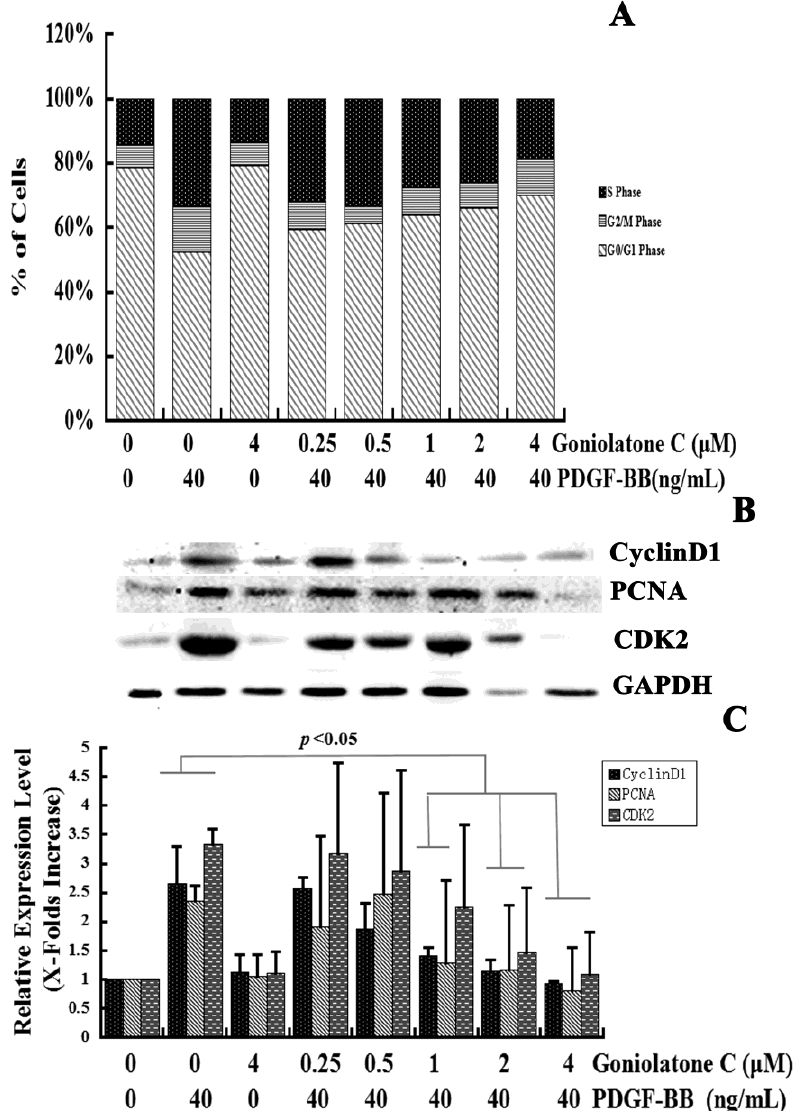
Figure 3. Goniolactone C induced G 0 /G 1 phase arrest during cell cycle progression. VSMCs were pre-incubated in the presence or absence of goniolactone C in serum-depleted medium for 12 h. The cells were then stimulated with 40 ng/mL of PDGF-BB for 24 h. ( A ) Individual nuclear DNA content was determined by measuring the fluorescence intensity of incorporated propidium iodide. Each value is derived from a representative experiment where data from at least 10,000 events were obtained. The data are expressed as the mean values from three independent experiments. ( B , C ) Western blot analyses were performed using antibodies specific for cyclin D1, CDK2 and PCNA. GAPDH was used for normalization. The relative levels of these proteins are expressed as x-fold increases compared to that of the normal control